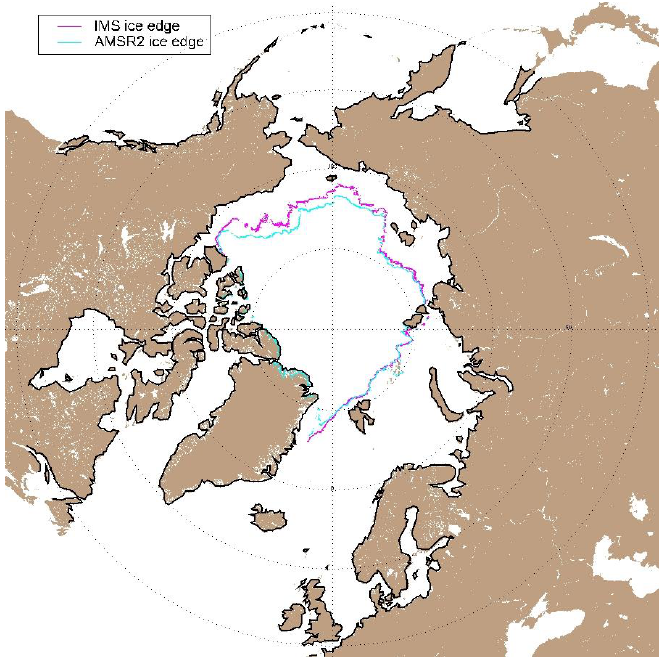
Figure 12. Median ice edge in August 2015–2019 from AMSR2 (Cyan) and from IMS (Magenta).